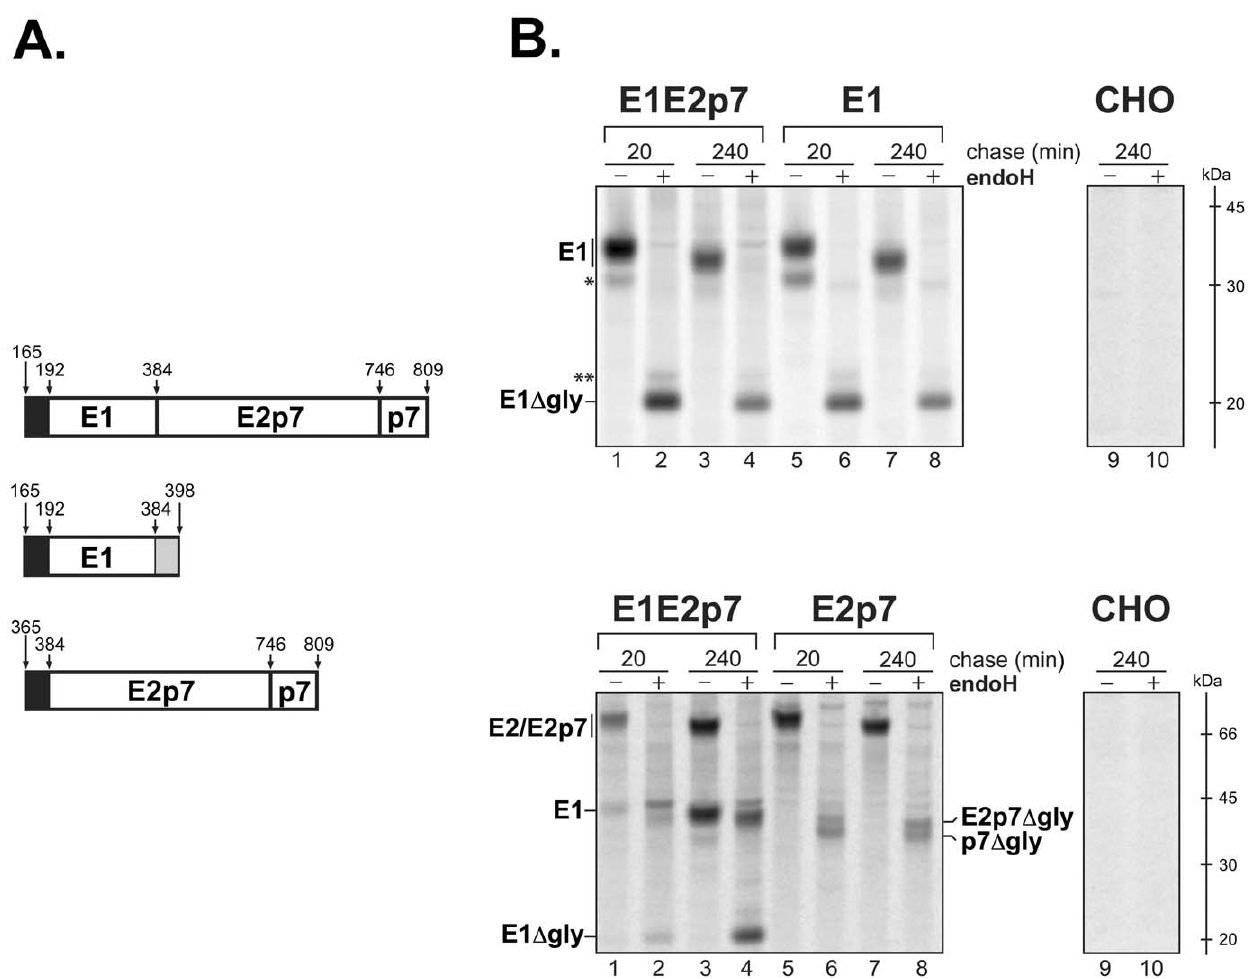
Figure 1. Endoglycosidase H sensitivity of HCV glycoproteins E1 and E2p7. (A) Recombinant constructs for E1, E2p7 and E1E2p7 expression in CHO cells. Sequences coding for the structural protein E1 (aa. 165–398), E2p7 (aa. 365–809) and E1E2p7 (aa. 165–809) were amplified from a replicon containing the entire HCV genome of HCV genotype 1b, subtype ConI as described in the Materials and Methods. These constructs were used to stably express the proteins in CHO cells. Black segments represent the E1 (aa. 165–191) and E2 (aa. 366–384) signal sequences. The N- terminus 15 amino acids of the E2 protein are shown as a dashed segment in the E1 construct. (B) CHO cells expressing E1, E2p7 or E1E2p7 were pulse-labeled with [ 35 S]-methionine and -cysteine for 20 min and chased for the indicated time periods. PNSs were immunoprecipitated with an anti- E1 (top panel) or anti-E2 antibody (lower panel) and further treated with ( + ) or without ( 2 ) EndoH. Proteins were separated on 10% SDS-PAGE in reducing conditions. Asterisks indicate non-specific bands. E1 D Gly indicates the E1 protein co-immunoprecipitated with the anti-E2 antibody and subsequentlydeglycosylated by EndoH treatment.